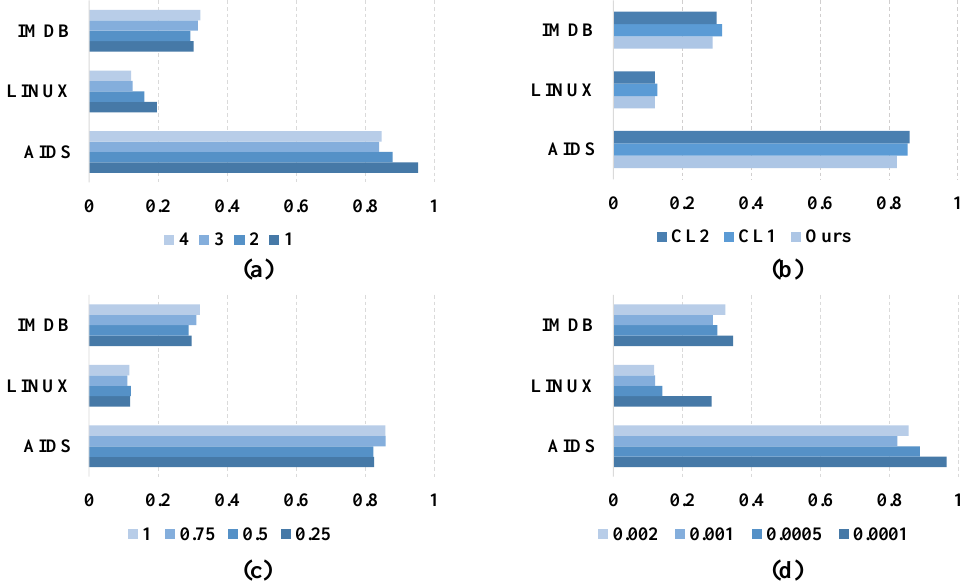
Figure 3. Mse results of the further analysis (in the scale of the 10 − 3 ). Lower values are preferred. ( a ) Experiment on GNN layers. ( b ) Experiment on graph augmentation in contrastive learning. ( c ) Experiment on loss function. ( d ) Experiment on learning